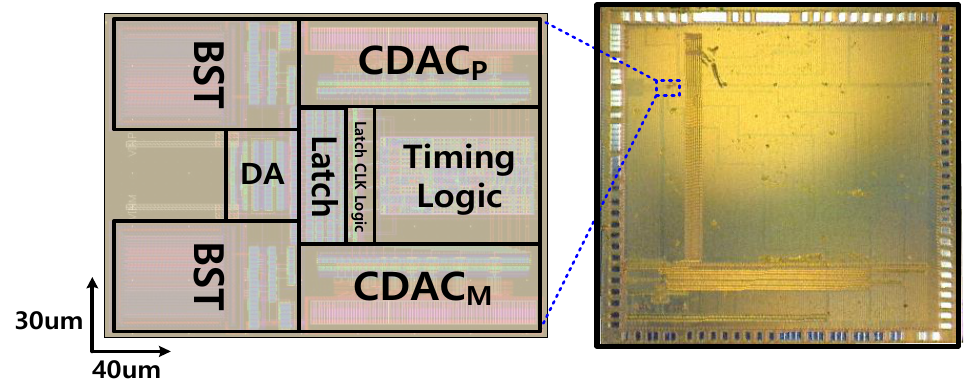
Figure 10. Die Figure 10. Die photograph.